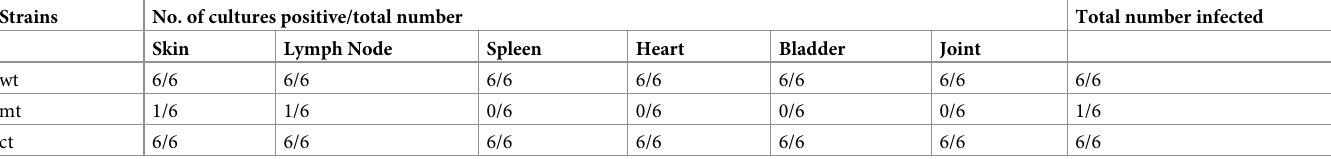
Table 3. Analysis of infectivity of C3H/HeN mice challenged with wt, mt and ct strains via infected Ixodes scapularis nymphs. Strains No. of cultures positive/total